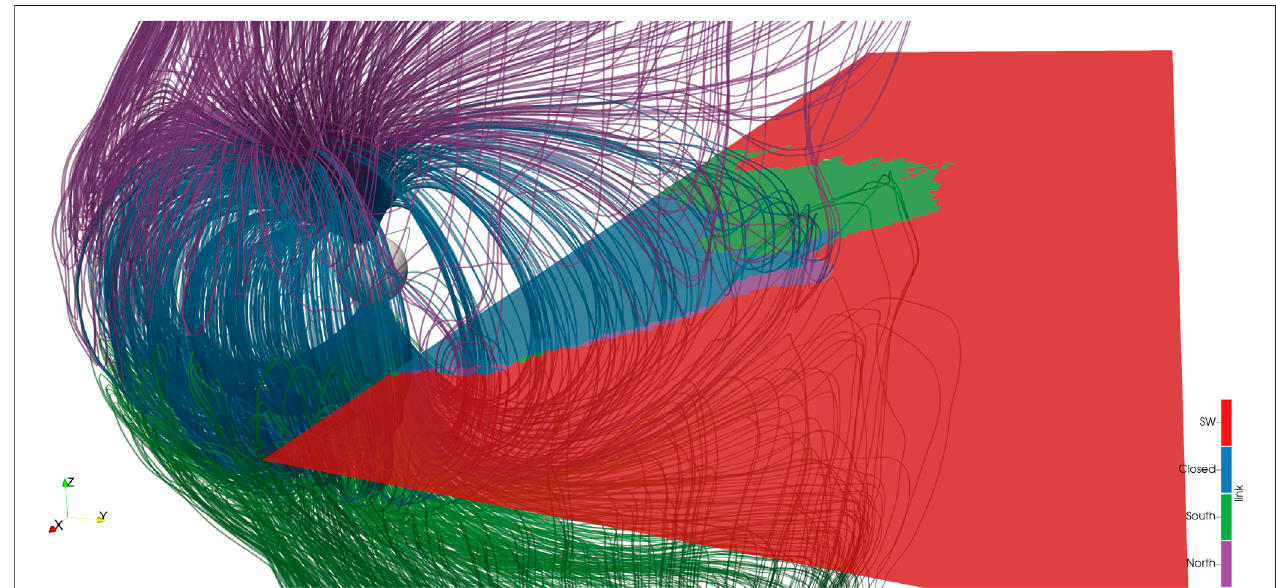
FIGURE4| Anexampleof fi eldlinetracingandtopologymapping.Themagnetic fi eldlinesarecoloredbytheirtopology:redforsolarwind,blueforclosed,greenfor open fi eldlinesconnectedtotheSouthpole(magneticNorth)andpurpleforopen fi eldlinesconnectedtotheNorthpole(magneticSouth).Thesolarwind(red) fi eldlines, which would dominate the view, have been fi ltered out. The slice shows the magnetic topology of cells along the ecliptic plane ( z GSE (cid:2) 0): i.e. fi eld lines connected to the red region are solar wind fi eld lines, and map to the outer boundary of the simulation.